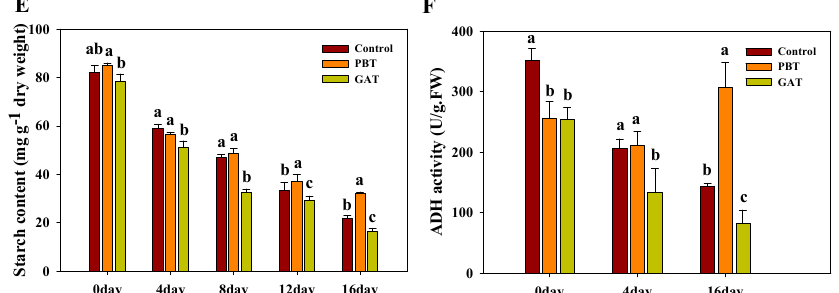
Figure 2. Physiological assay of control, GAT, and PBT seedlings under submergence. ( A ) Seedling survival rate of control, GAT, and PBT seedlings after submergence for 0, 4, 8, 12, and 16 days; ( B ) plant height of control, GAT, and PBT seedlings after submergence for 0, 4, 8, 12, and 16 days; ( C ) SPAD value of control, GAT, and PBT seedlings after submergence for 0, 4, 8, 12, and 16 days; ( D ) soluble carbohydrate content of control, GAT, and PBT seedlings after submergence for 0, 4, 8, 12 and 16 days; ( E ) starch content of control, GAT, and PBT seedlings after submergence for 0, 4, 8, 12 and 16 days; ( F ) ADH activity of control, GAT, and PBT seedlings after submergence for 0, 4 and 16 days. Values are the means ± SD (standard deviation) of 10 plants as 10 replicates for plant height and SPAD (soil and plant analyzer development) value, and four pots of plants as four replicates for NSC (non structural carbohydrate), and three pots of plants as three replicates for survival rate and ADH (alcohol dehydrogenase) activity. Bars with different letters indicate significant differences in samples among groups at the same time point at p < 0.05 (Duncan’s test).